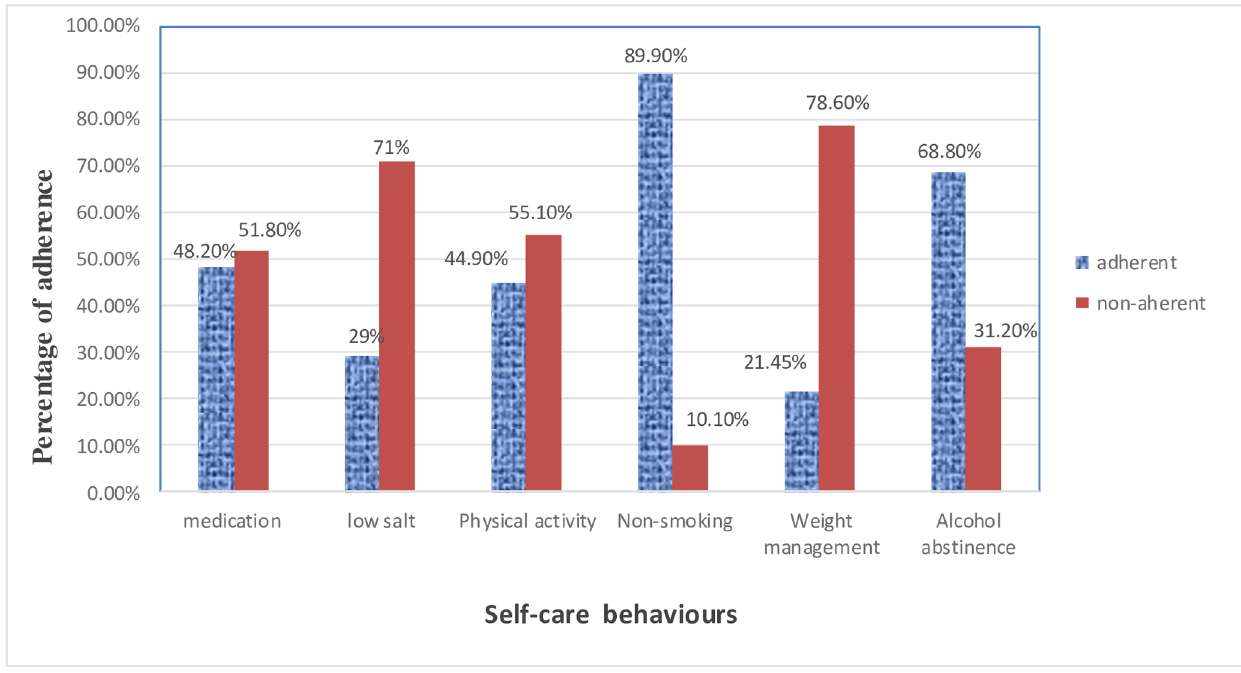
Fig 1. Prevalence of adherence to self-care behaviors among hypertensive patients in ACSH, 2017 (n = 276).